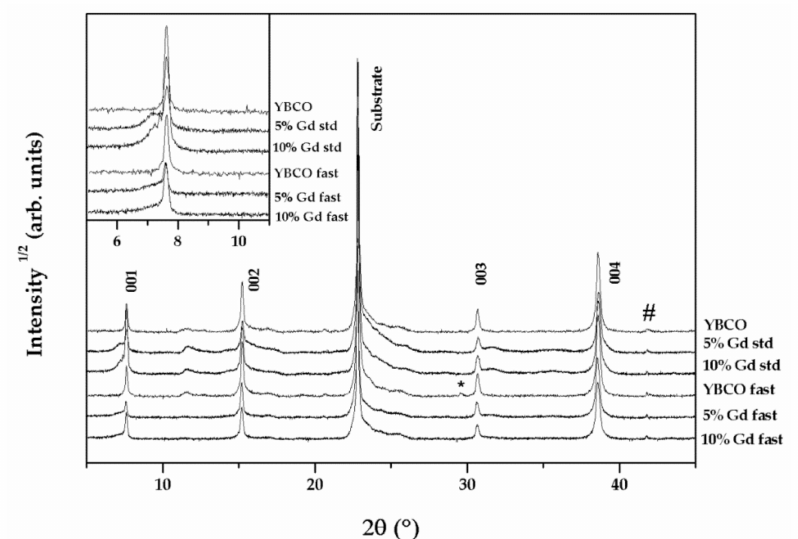
Figure1. X-ray θ -2 θ patternsofthedi ff erentsamplesdepositedbystandard(std)andfastprocess. YBCO 00 (cid:96) peaks are indicated, while * is ascribable to a Y-Ti-O secondary phase due to the solution-substrate interaction [34]. The symbol # indicates the K β peak of the substrate. In the inset: detail of YBCO 001 reflections. Table 2. Results of the XRD analysis for the di ff erent samples deposited by the standard and